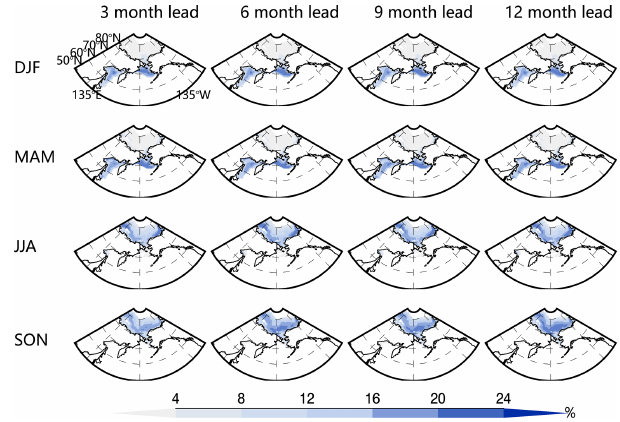
Figure 7. Same as Fig. 6 except for RMSEs. The color bar is in a unit of percentage.